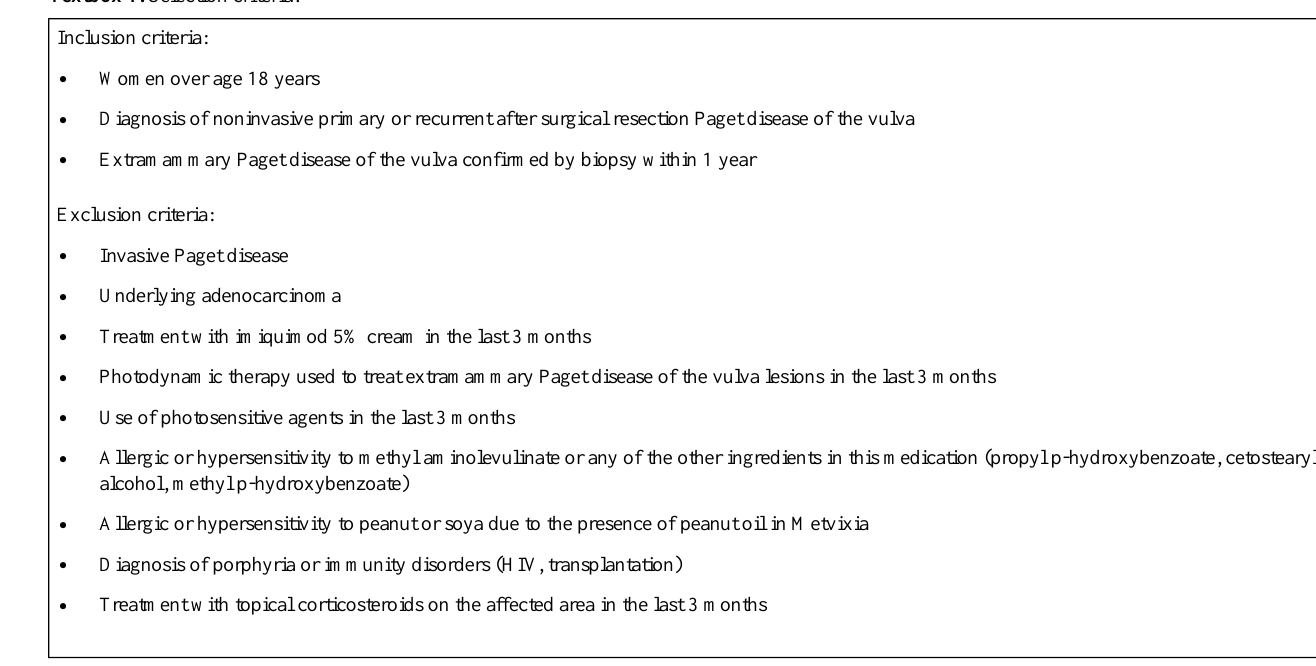
evaluation of adverse and serious adverse events. Key secondary objectives are the disease control rate at 6 months, evolution of the quality of life, level of pain during PDT session, presence of Paget cells after staining of biopsies, presence of fluorescence in selected lesion after each PDT session, and evaluation of the tolerability and overall satisfaction level of the patient. Table 1 below details study objectives and